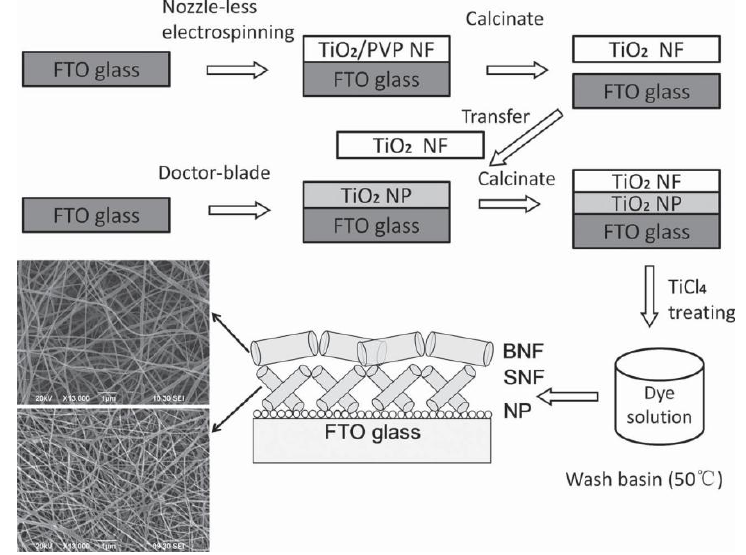
Figure 7. Schematic diagram of the fabrication procedure and SEM images of the bilayer TiO 2 nanofiber photoanode (BNF: bigger-diameter nanofiber; SNF: smaller-diameter nanofiber). photoanode (BNF: bigger-diameter nanofiber; SNF: smaller-diameter nanofiber). Reproduced with Reproduced with permission from [187]. Copyright Wiley, 2011. permission from [187]. Copyright Wiley,